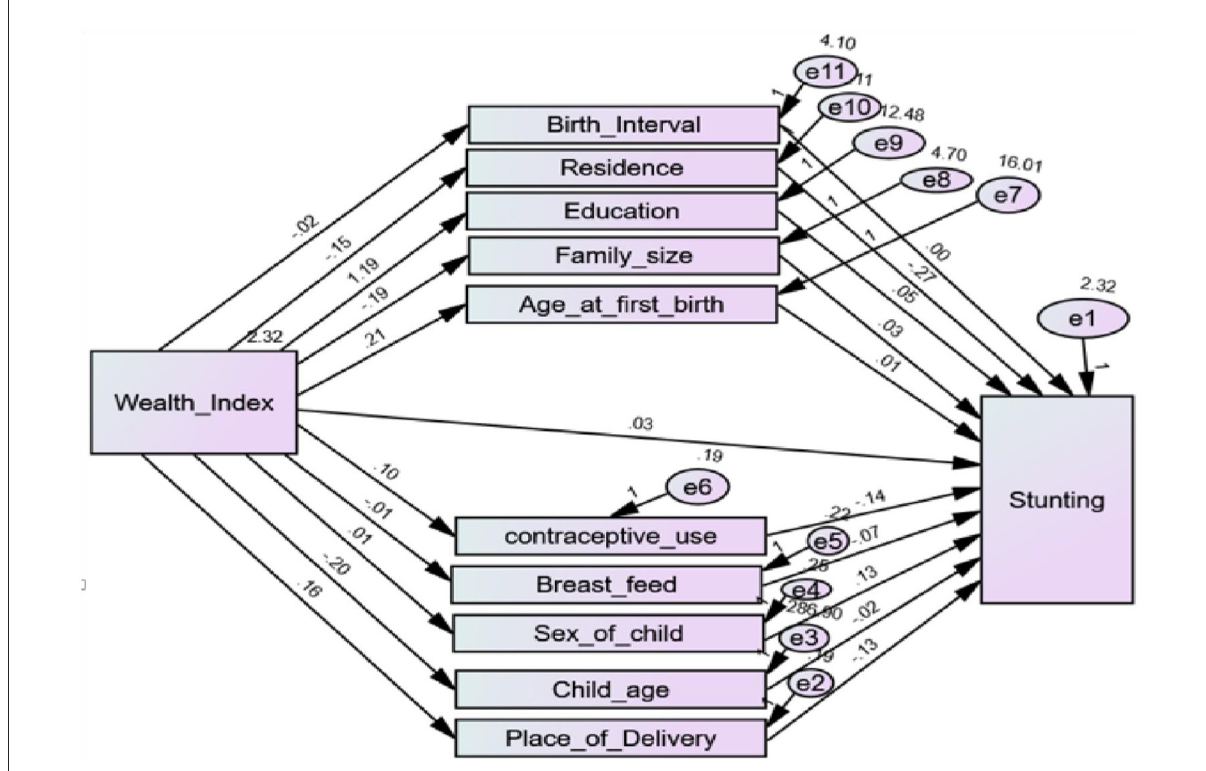
FIGURE3 Path diagram of mediators of the link between the wealth index and